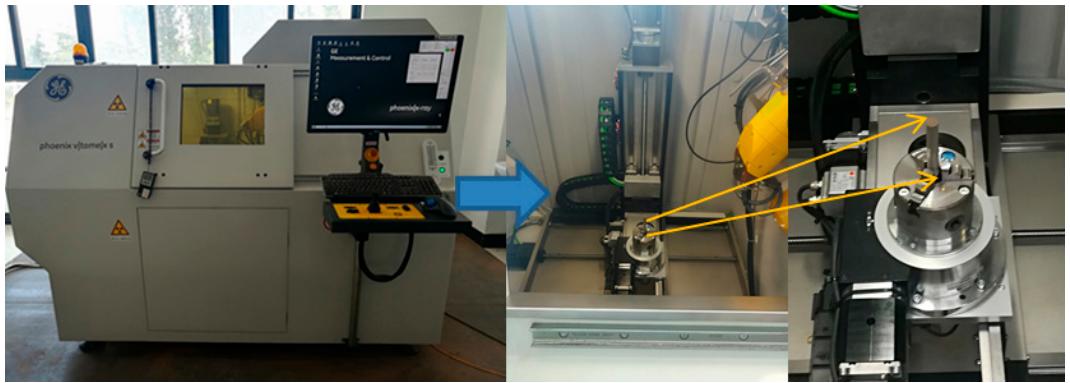
Figure 5. High-precision industrial CT scanning of compressed bed.